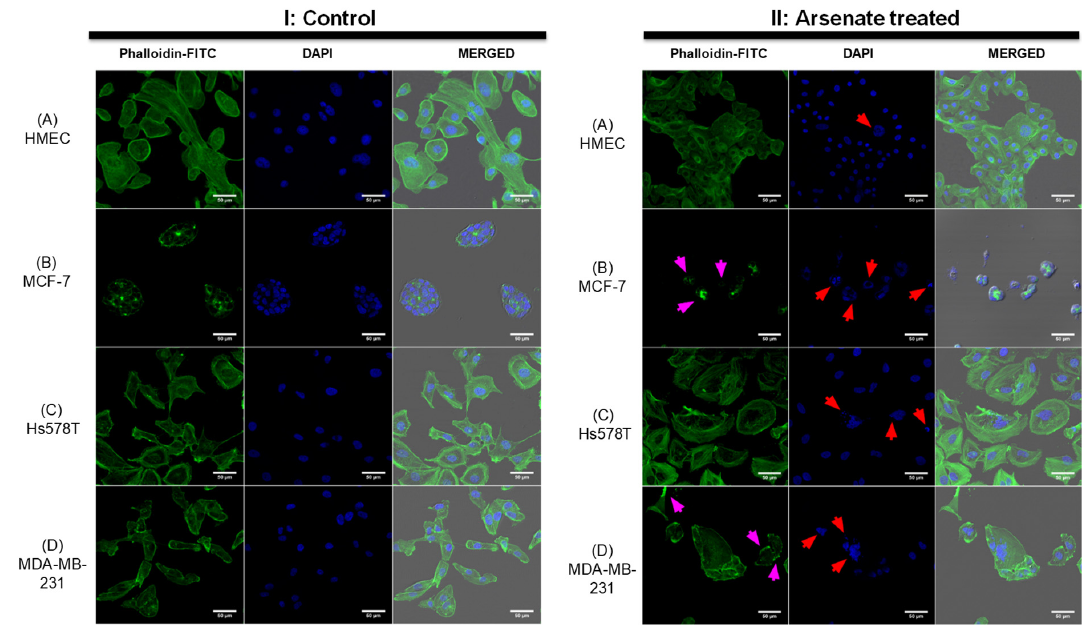
Figure 3. Changes in the cytoskeleton after arsenate exposure ( II ) with cytoskeleton staining by Phalloidin-FITC and nucleus staining by DAPI in comparison to control ( I ). Magnification of 50 μ m. ( A )—HMEC; ( B )—MCF-7; ( C )—Hs578T; ( D )—MDA-MB-231. Note in ( II ) the completely disorganized actin cytoskeleton in the case of the MCF-7 cell line and the increased amount of actin filaments at the cell membrane of the MDA-MB-231 cell line affecting cytoskeletal organization. Red arrows point to irregular or fragmented nuclei and magenta arrows indicate cytoskeleton damage. Alterations are more prominent in all cancer cell lines compared to the HMEC cell line where the actin filaments are not affected and nuclear damage is insignificant.